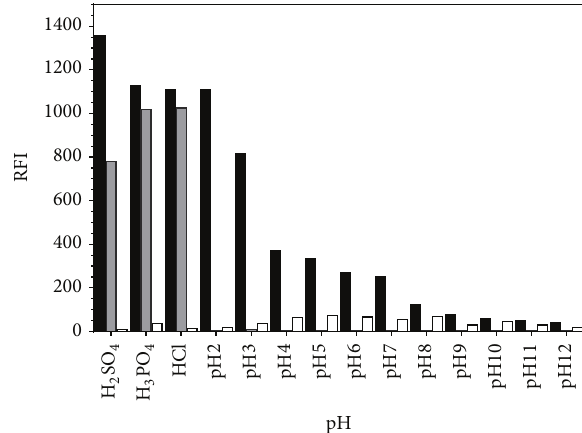
Figure 5: Effect of pH on the RFI of 100 ng/mL MRZ in 0.2 mL 1%, w/v sodium lauryl sulfate (SLS) in aqueous solution (black column MRZ-SLS, grey column MRZ alone, and white column SLS